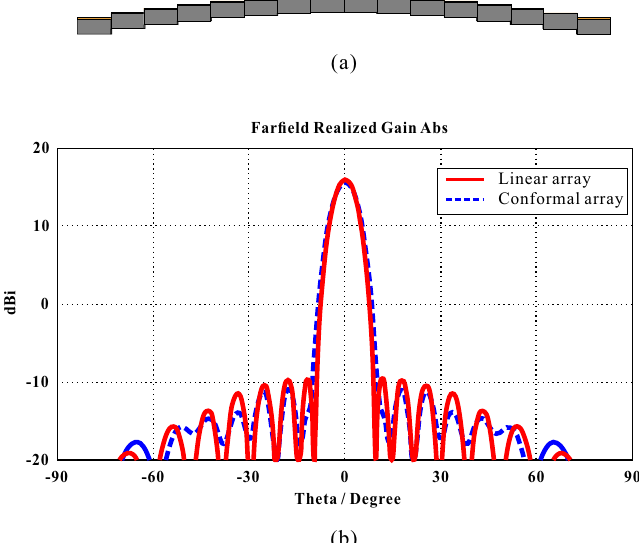
Figure 12. Application of the calculated amplitude based on the optimization trend: ( a ) conformal array shape with amplitude applied and ( b ) 1 × 16 conformal array radiation pattern vs. linear array radiation pattern.